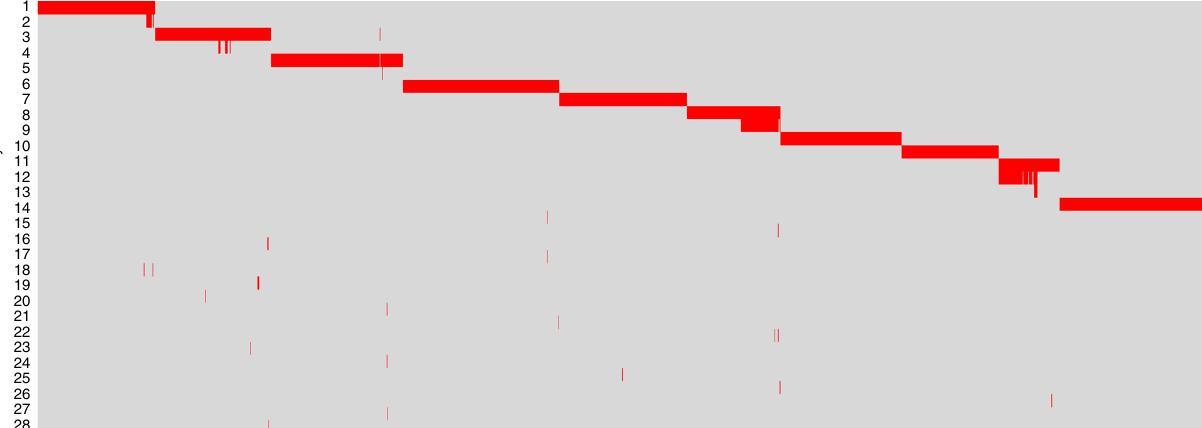
Fig. 6 Presence – absence matrix of Acr families in genomic contexts. A binary matrix where each column is a distinct genomic neighborhood (ordered by similarity) and each row represents an Acr family. Each cell represents the presence or absence of a member from the Acr family in the neighborhood, with red for presence and gray